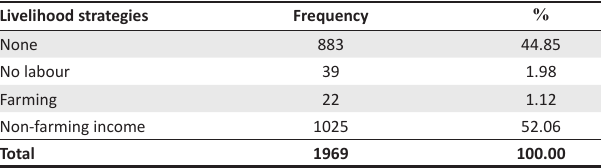
FIG URE 3: Receiver operating characteristic curve - Food security model. TABLE 10: Livelihood strategies.